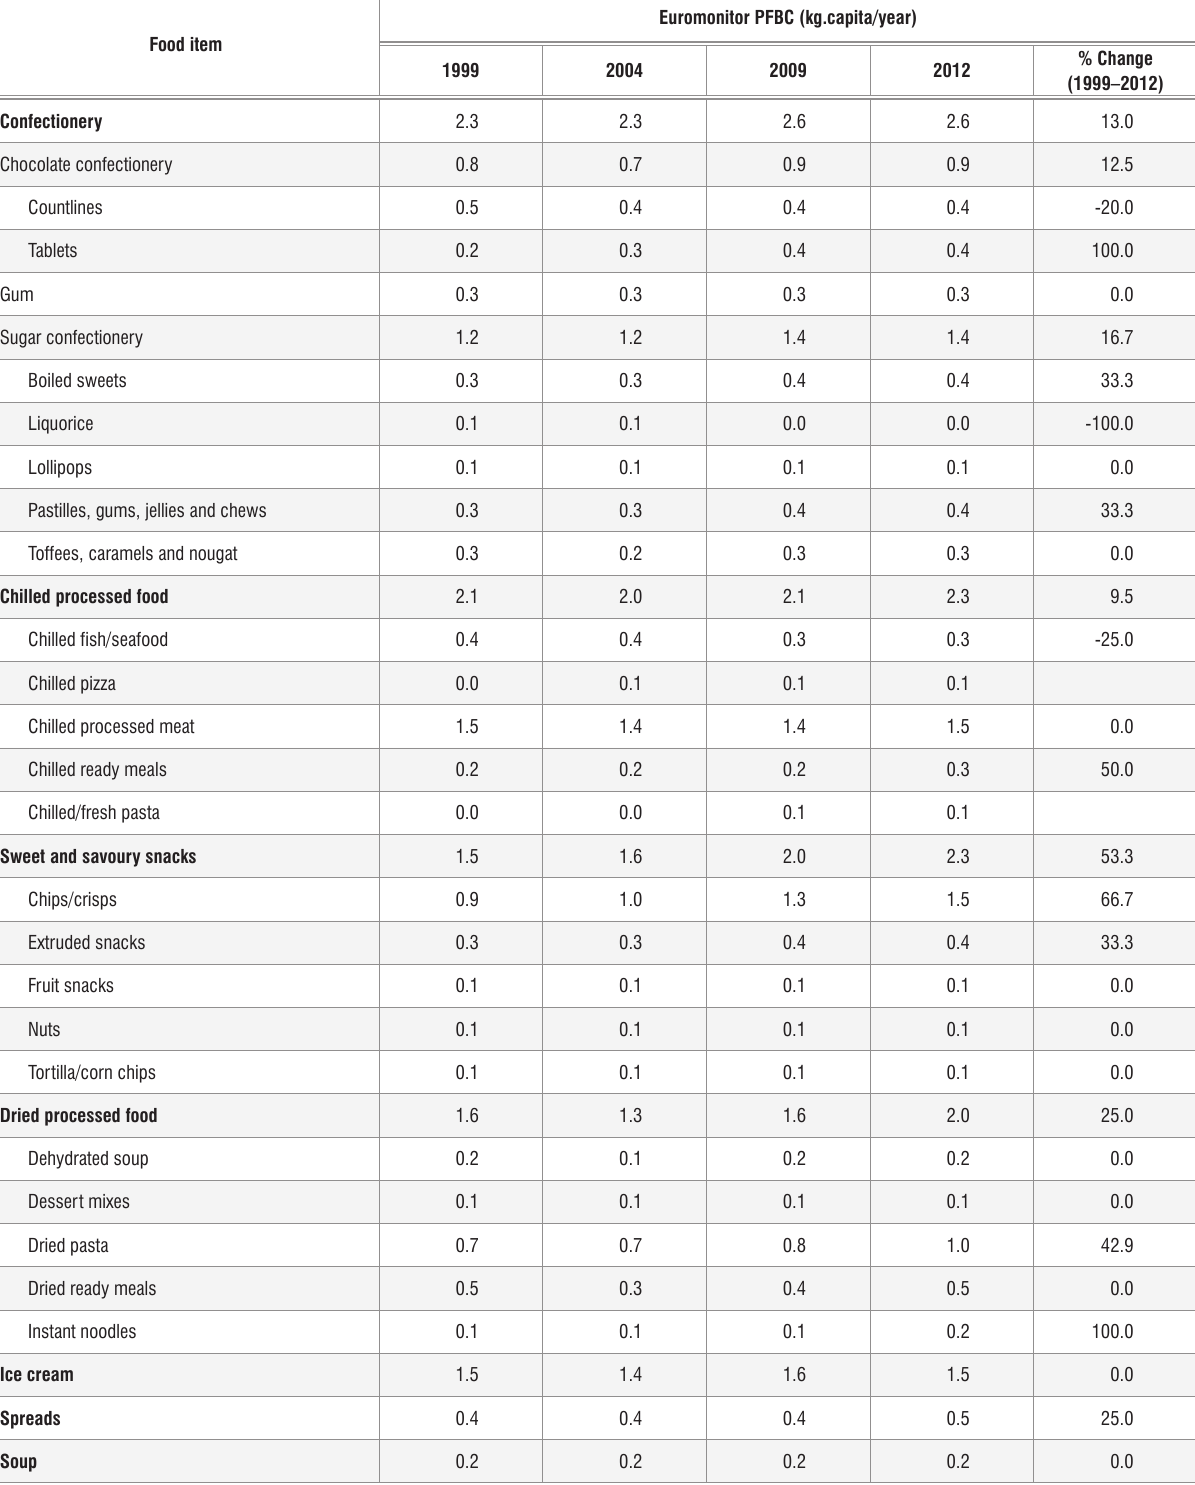
(Table 8). Convenience is the driver of the increase 56 as the number of consumers with freezers is increasing.